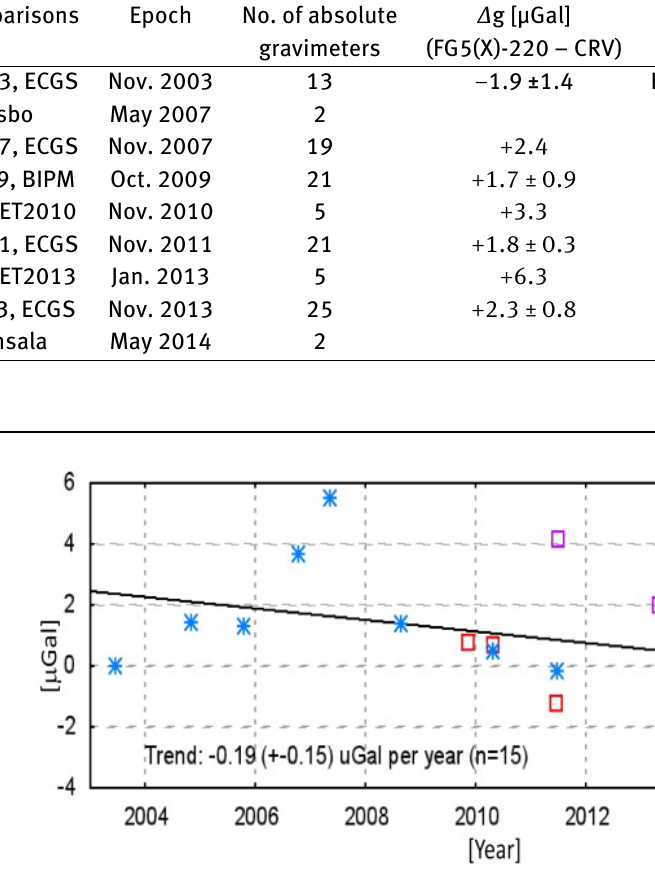
Figure 4: Gravity variations at Onsala as obtained with the FG5 gravimeters of LM and LUH, after applying reductions from SCG GWR#54 (available since